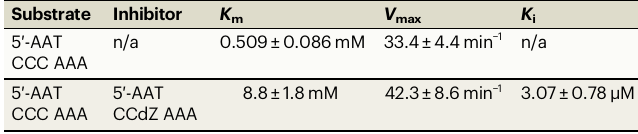
Table 1 | K D values from Micro Scale Thermophoresis